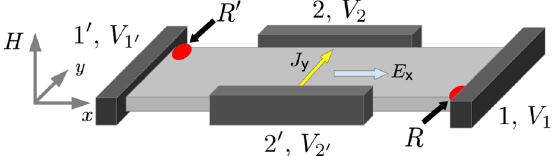
FIG. 5. A Hall-bar geometry with four Ohmic contacts, with a uniform magnetic field H pointing in the z direction producing a Hall effect in the electric conduction equation (6) for the material. Experiments on a thin, three-dimensional doped germanium crystal were reported in 1953 [27], which attempted to realize the gyrator (four-terminal labeling corresponding to Fig. 3), with a signal field E exciting a Hall current J . Intrinsic inhomoge- x y neities in the field distribution cause this device to have high losses, preventing it from successfully approximating the ideal gyrator. For large Hall angle, the losses become concentrated at “ hot spots ” at the points R and R 0